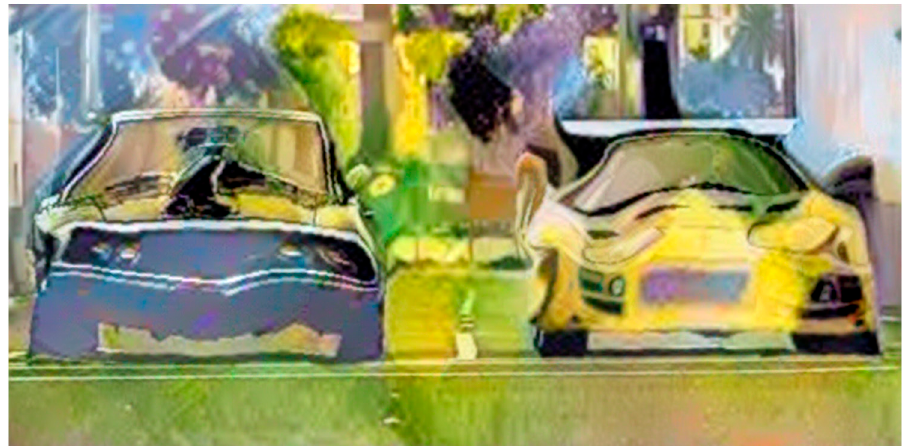
Figure 6. Results using the proposed method.